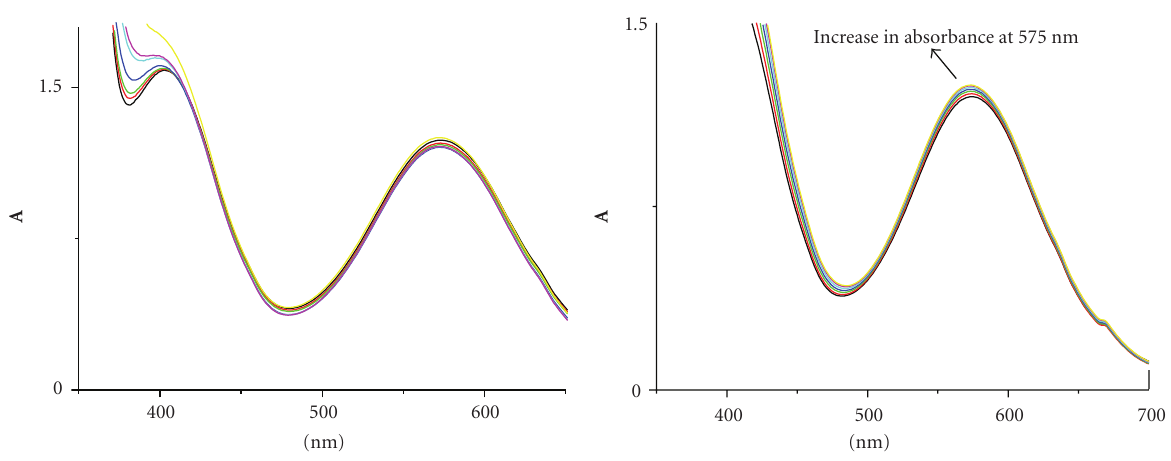
Figure 5: (a) UV-Vis spectra of the reaction mixture Cr(III)/2,4-DHBA. Spectra on the left: [2,4-DHBA] = 8,85 · 10 − 3 M, [Cr(III)] = 0,067 M,T = 288 K. Spectra on the right: [2,4-DHBA] = 8,85 · 10 − 3 M, [Cr(III)] = 0,09 M, T = 298 K. (b) UV-Vis spectra of the reaction mixture Cr(III)/2,5-DHBA. Spectra on the left: [2,5-DHBA] = 8,85 · 10 − 3 M, [Cr(III)] = 0,09 M,T = 288 K. Spectra on the right: [2,5-DHBA] = 8,85 · 10 − 3 M, [Cr(III)] = 0,09 M, T =